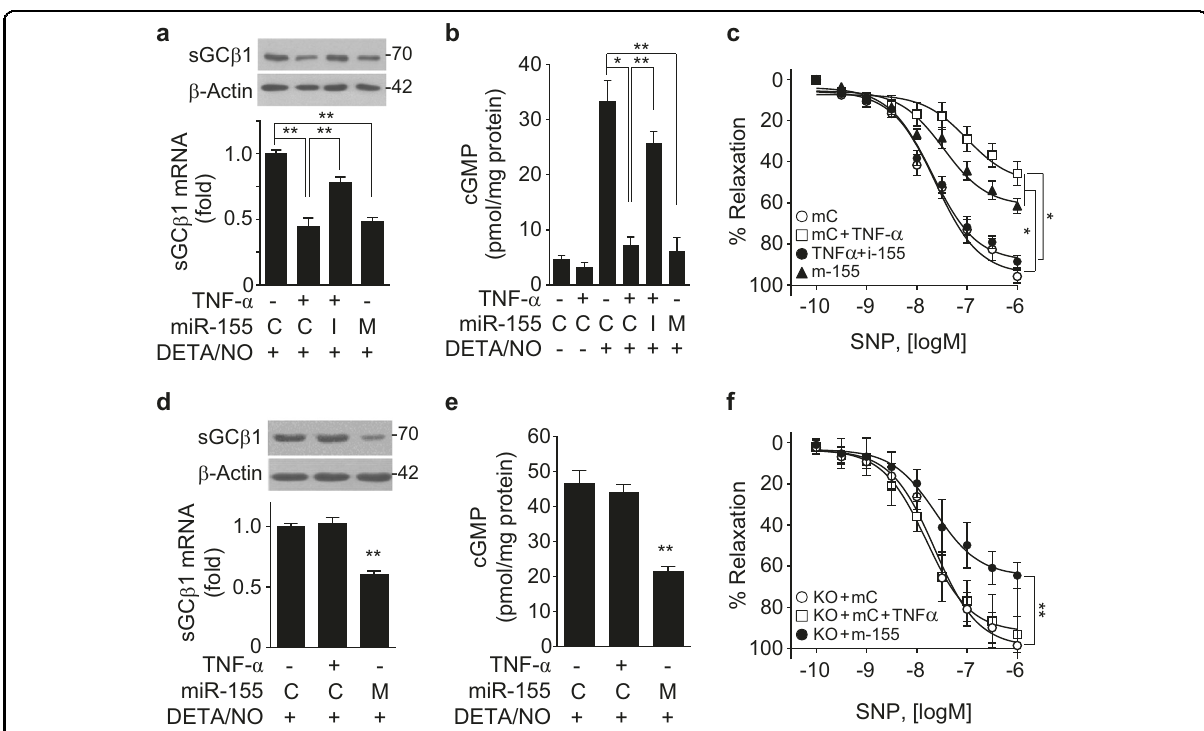
Fig. 6 MiR-155 suppresses vasorelaxation by inhibiting the sGC/cGMP pathway. a Mouse de-endothelialized aortic rings were transfected with 100 nM of control miRNA (C), miR-155 mimic (M), or miR-155 inhibitor (I), followed by treatment with or without TNF- α (20 ng/mL) for 24 h. The sGC β 1 mRNA and protein levels were determined by qRT-PCR ( n = 3) and Western blotting. b De-endothelialized aortic rings were transfected with miR-155 mimic and miR-155 inhibitor and stimulated with or without TNF- α for 24 h, followed by treatment with DETA/NO for another 24 h. The cGMP levels were determined in vessel lysates using a cGMP assay kit ( n = 3). c De-endothelialized aortic rings were transfected with control miRNA, miR-155 mimic (m-155), or miR-155 inhibitor (i-155), followed by treatment with TNF- α for 24 h. The cumulative vascular relaxation response of the aortic rings to SNP was measured by myography ( n = 8). d – f De-endothelialized aortic rings from miR-155 − / − (KO) mice were transfected with 100 nM of control miRNA (C, mC) or miR-155 mimic (M, m-155) and stimulated with or without TNF- α for 24 h, followed by treatment with DETA/NO (100 μ M) for another 24 h. d The sGC β 1 mRNA levels were determined ( n = 5). e The cGMP levels were determined using a cGMP assay kit ( n =